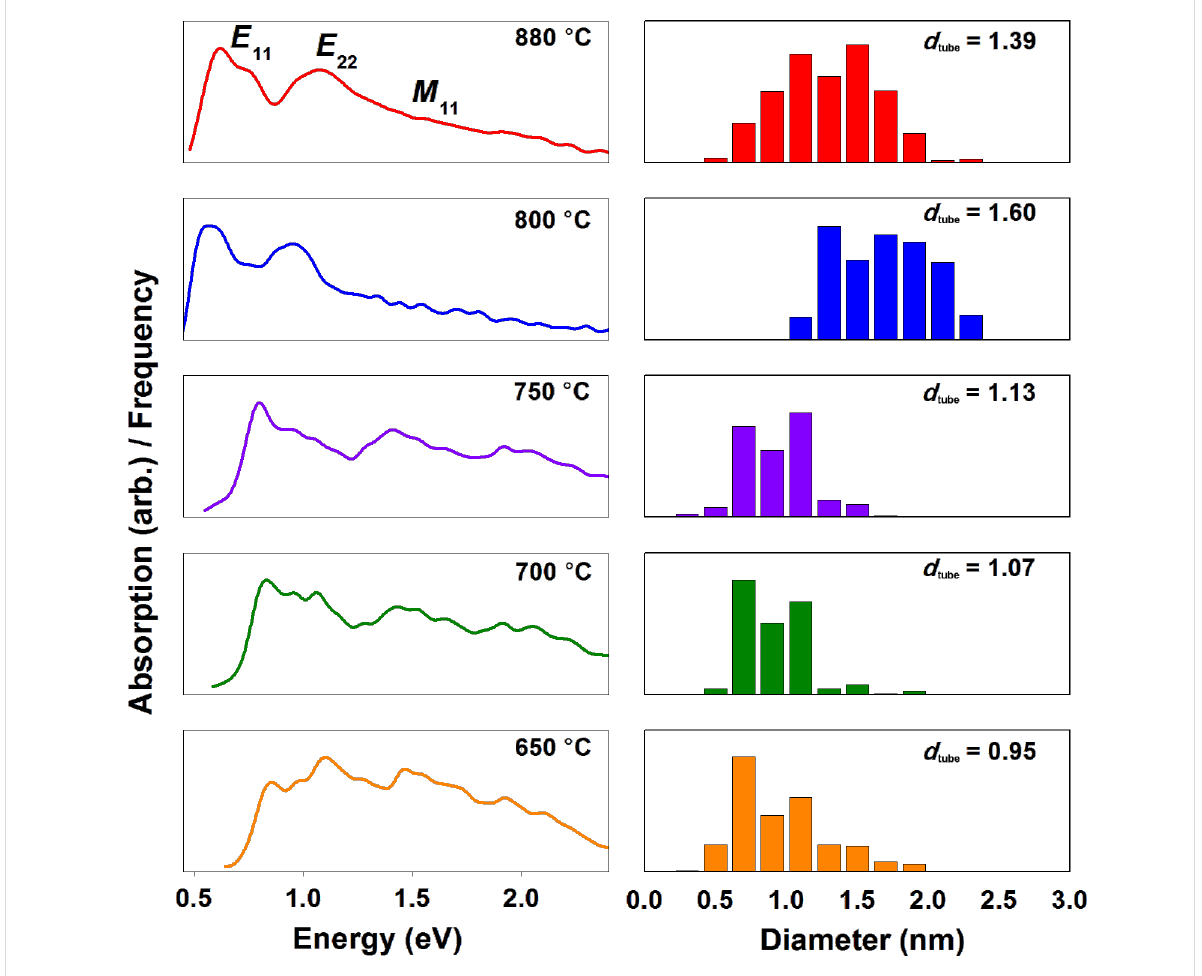
Figure 5: UV–vis–NIR absorption spectra (left) from the SWCNTs synthesized under different temperature conditions (650–880 °C) and the SWCNT diameter distributions (right) fitted to each spectrum.